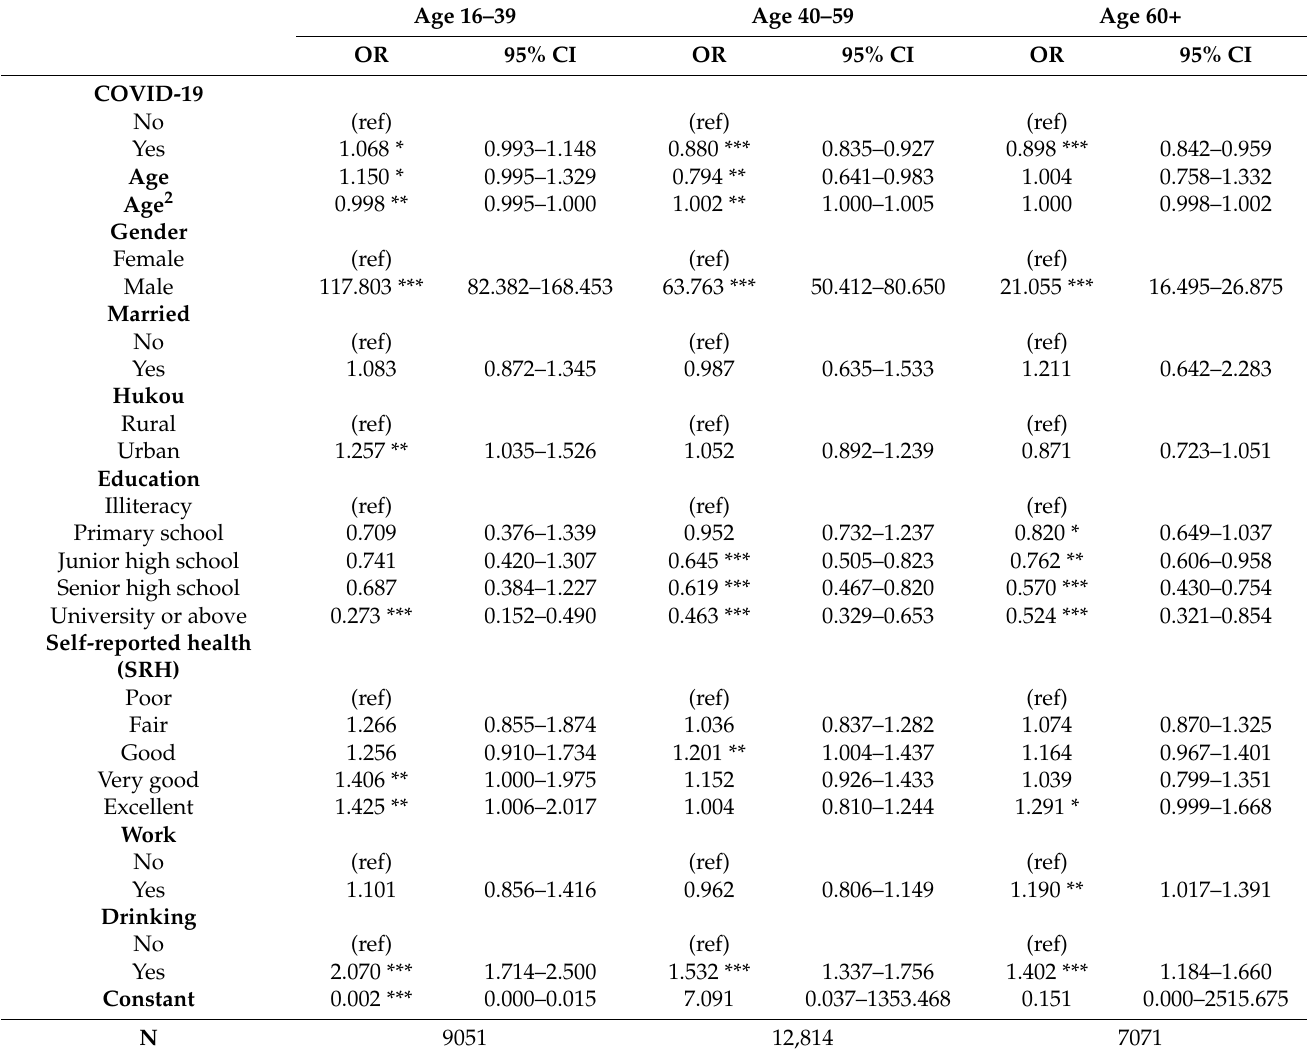
Table 3. Logit regression results for the effects of COVID-19 pandemic on smoking behavior. Age 16–39 Age 40–59 Age 60+ OR 95% CI OR 95% CI OR 95%